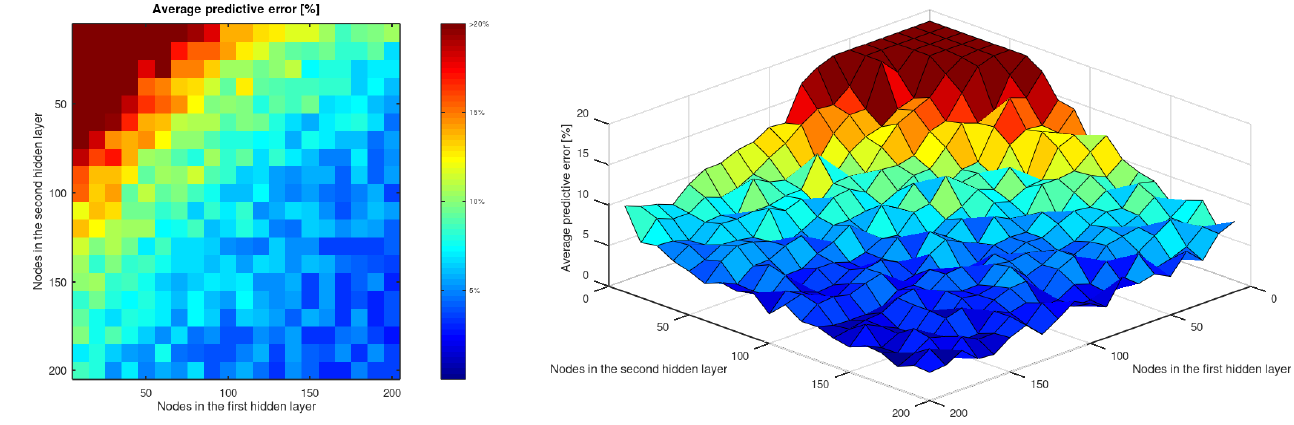
Figure 3. Average predictive error [%] (trimmed above